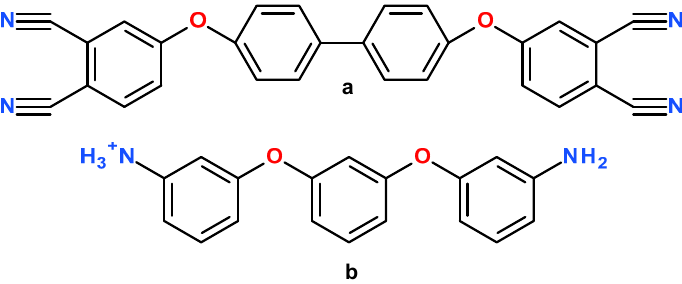
Figure 1. Molecular structure of ( a ) BPh monomer and ( b ) activated m-APB cross-linking agent.